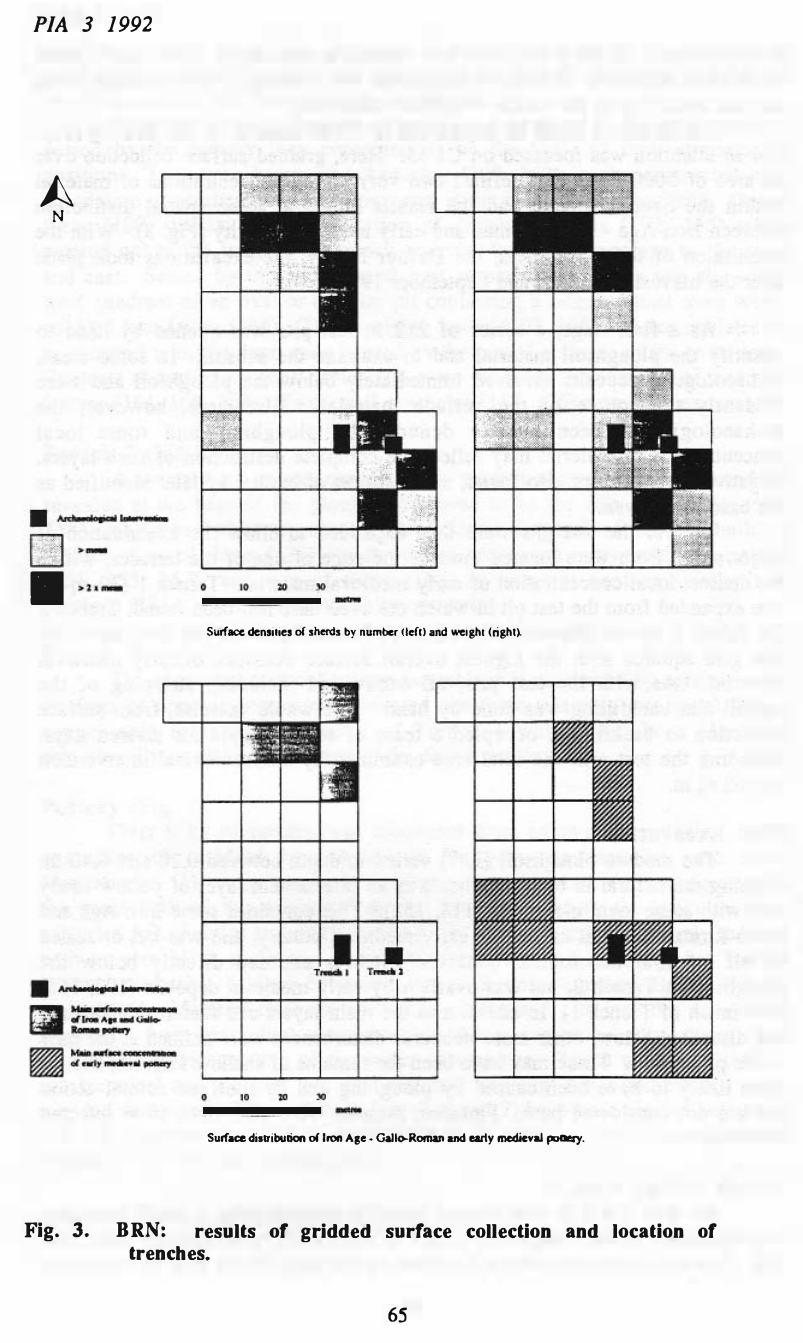
Fig. 3. BRN: results of gridded surface collection and location of